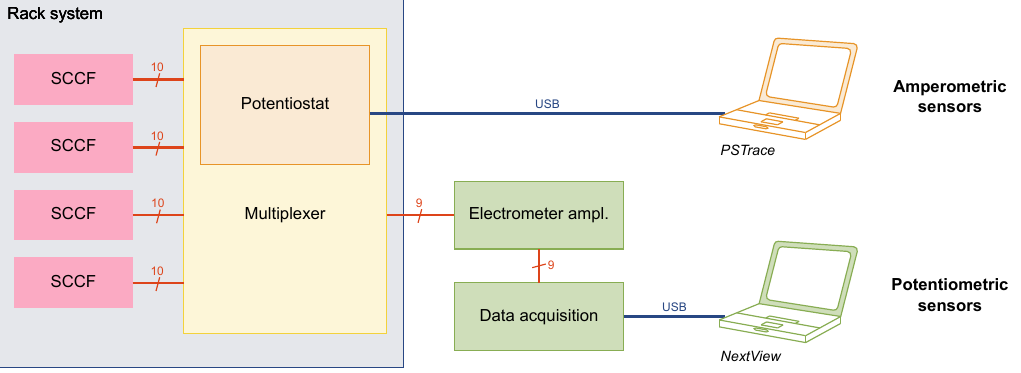
Figure 3. Block diagram of the SCCF instrumentation: Four flasks can be inserted into the rack system. Amperometric measurements are realized by a single-channel potentiostat integrated into a custom-made multiplexer. Potentiometric measurements can run continuously by a multichannel electrometer amplifier and data acquisition